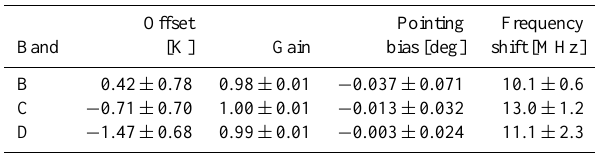
Fig. 3. (a) Retrieved reduced χ 2 for PrEx 1 flight for each scan as a function of time. (b) Trace of AK matrix for each scan as a function of time. The length of the state vectors is 59 elements in band B, 63 in band C and 57 in band D. (c) Information content for each scan as a function of time. Blue for band B, black for band C and red for band D. Table 3. Degrees of Freedom of the three MARSCHALS bands for Table 4. Average scalar quantities retrieved from the three the vertically resolved targets. MARSCHALS